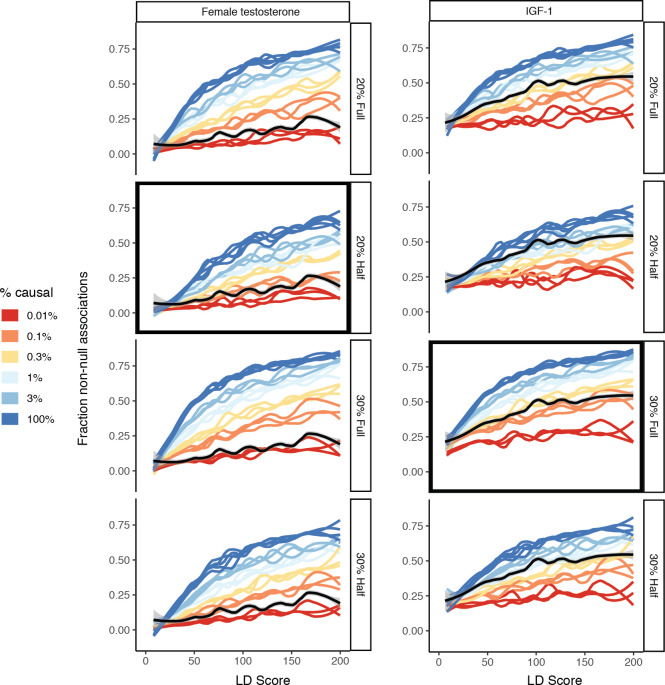
Effect of mis-specification of SNP-based heritability or sample size in the simulation matching approach.For female testosterone (left) and IGF-1 (right), the correct specification that corresponds to the trait is selected in black. All other estimates are given as well, revealing that the choice of SNP-based heritability and sample size does have a moderate effect on the resulting estimates. As such, we recommend matching the sample size and SNP-based heritability of the simulation GWAS as closely as possible to the traits under study.